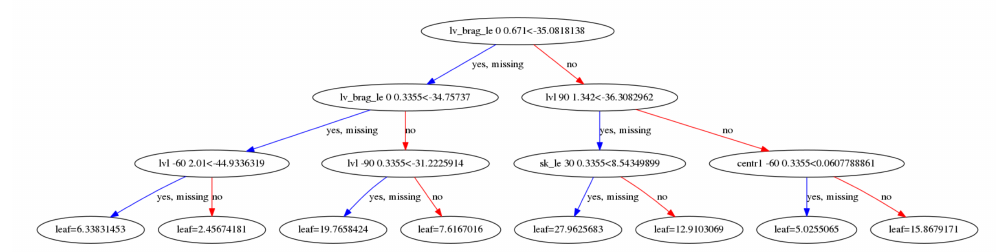
Figure 6. An example of the decision tree of depth 4 for North projection formed by XGBoost for 2020 Hz